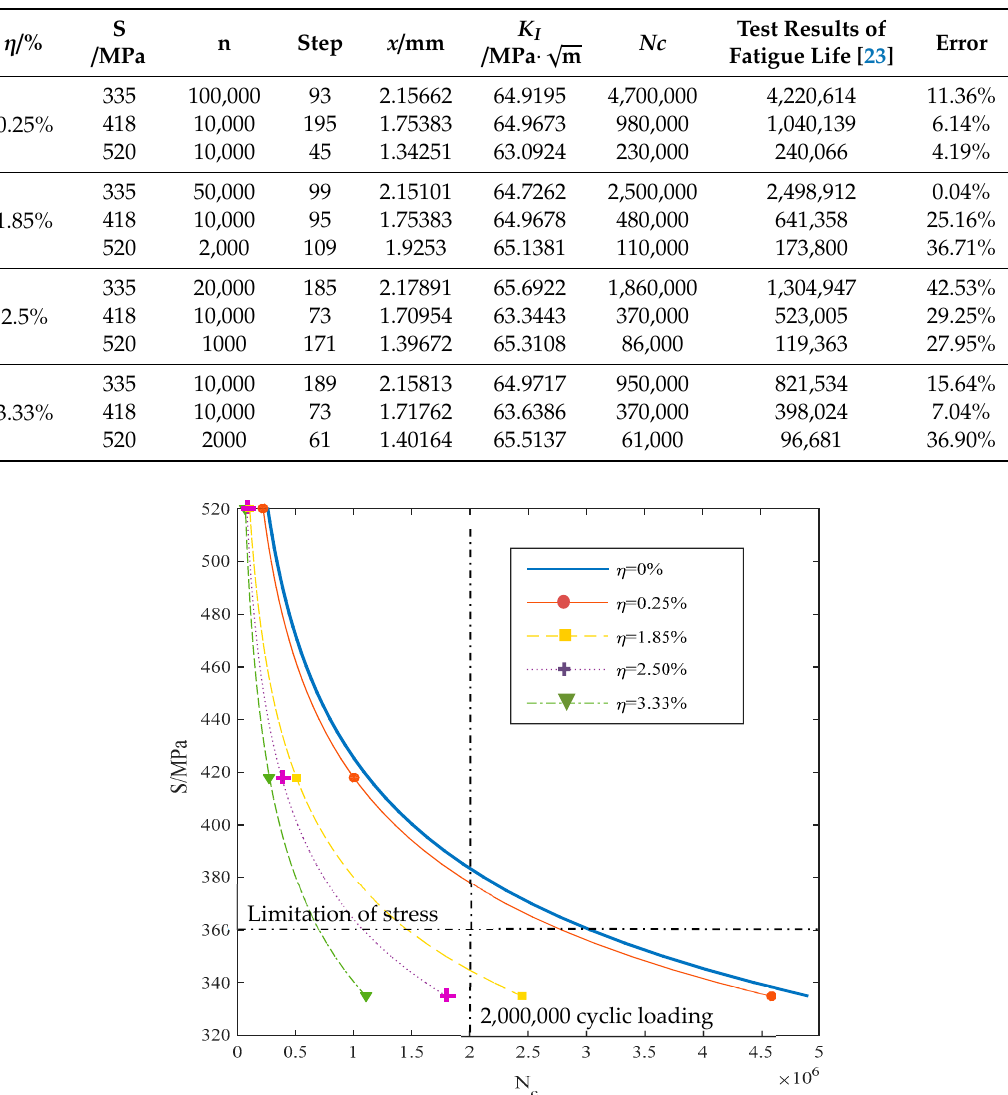
Table 1. Life of pre-corroded steel wire.